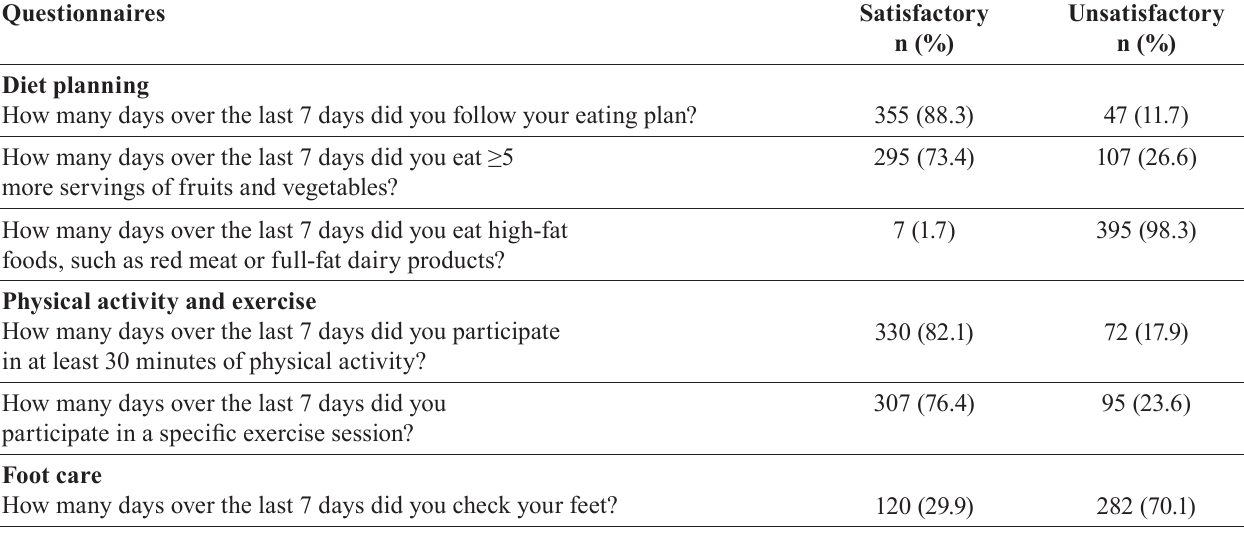
TABLE III - Satisfactory and unsatisfactory responses to self-care practice Questionnaires